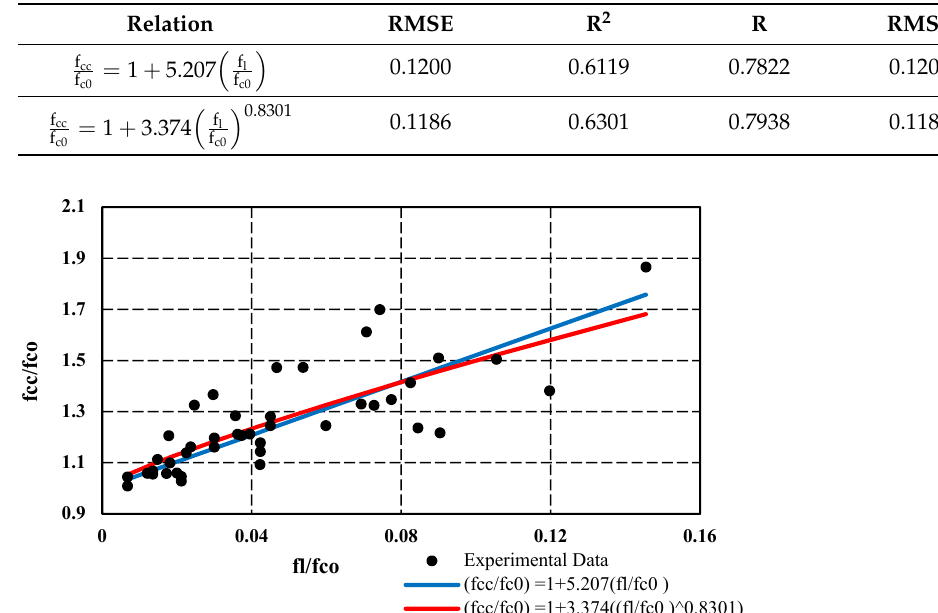
Table 3. Regression analysis results of Equations (2) and (3).